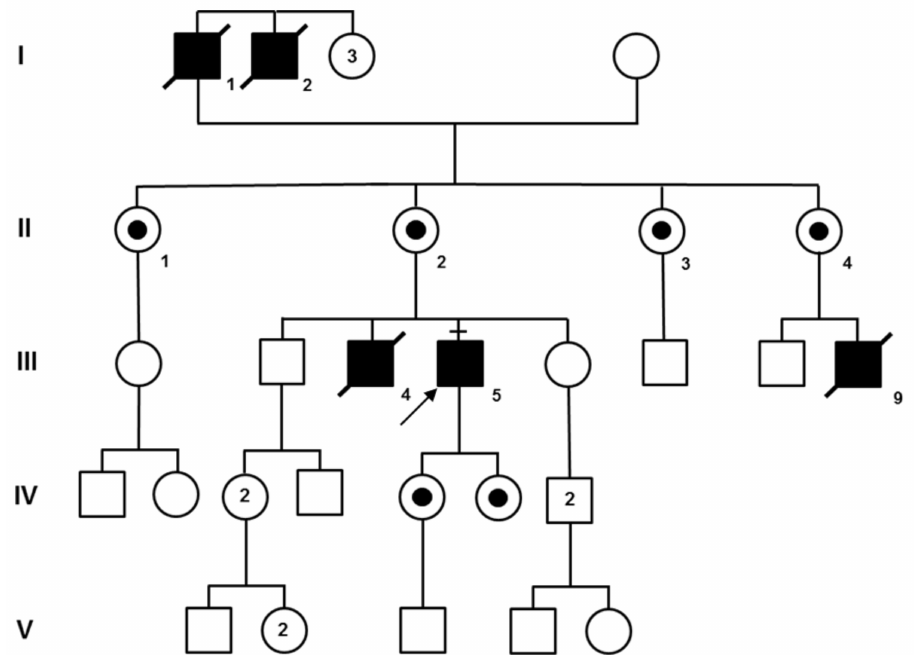
Figure 2. Pedigree of family F is compatible with X-linked inheritance. The molecular test of III:5 indirectly confirmed the diagnosis of McLeod syndrome for the other patients (I:1, I:2, III:4, and III:9) who had already died. Obligate carriers are indicated with a small black circle within their